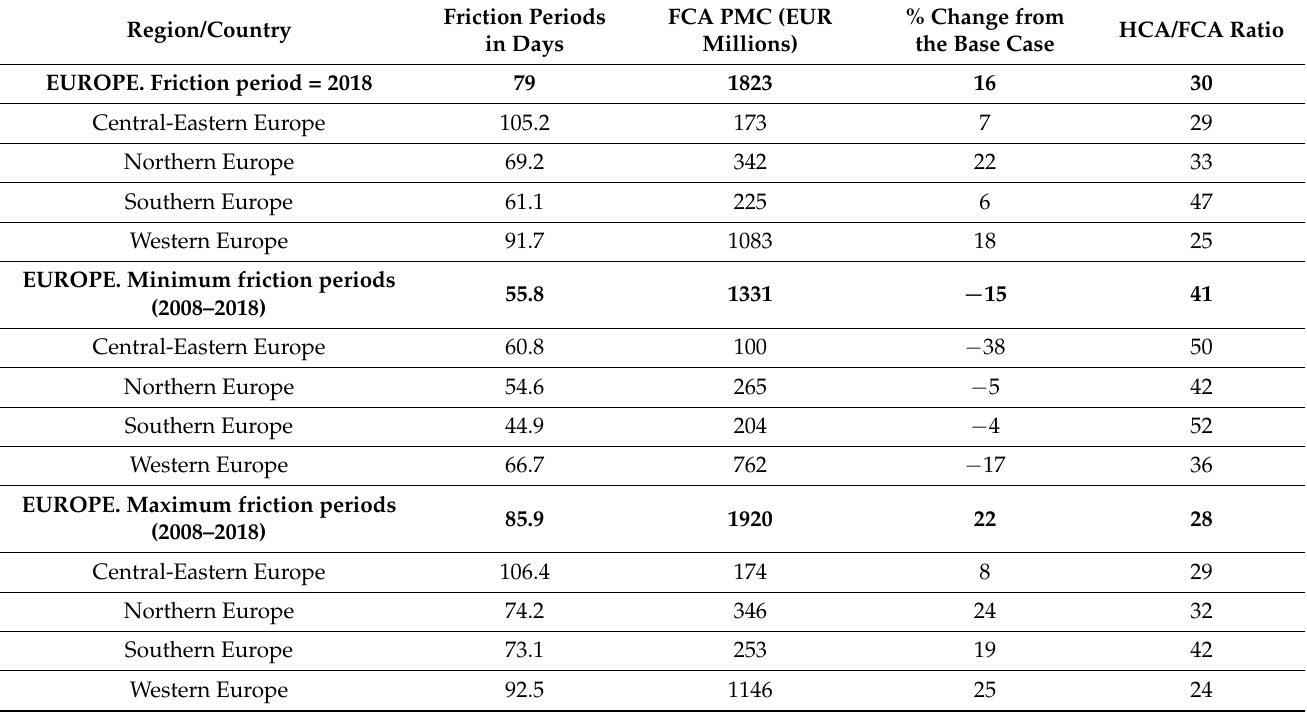
Table 5. Sensitivity analysis of cancer-related premature mortality costs (PMC) (EUR, total) using the Friction Cost Approach with comparison to the base case